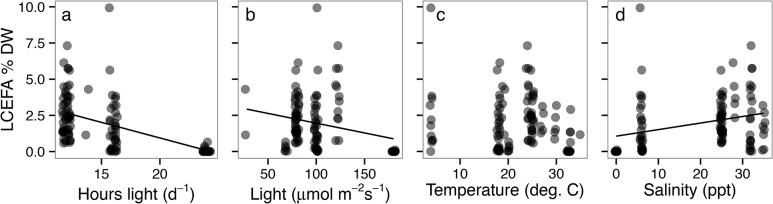
Post-hoc correlations between continuous culture conditions and the Σ LCEFA in the % DW dataset.Panels: (a) hours light, (b) light intensity, (c) temperature, and (d) salinity for all phytoplankton groups pooled together. Each point is from a different % DW fatty acid profile (i.e., not species means), and all points are the same tone of grey, but are plotted with semi-transparency and jittering to accommodate for overplotting of points with similar values. Best-fit lines are significant (Kendall’s Tau, p<0.05).